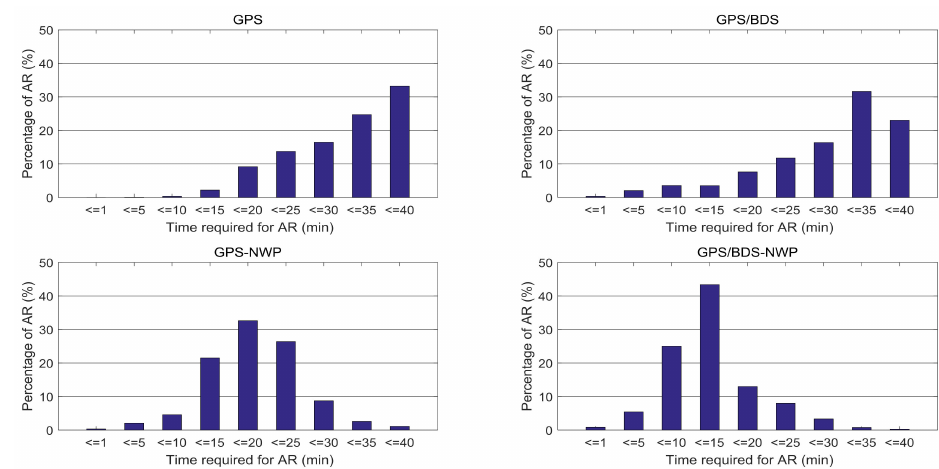
Figure 8. Time required for AR (baseline: 260